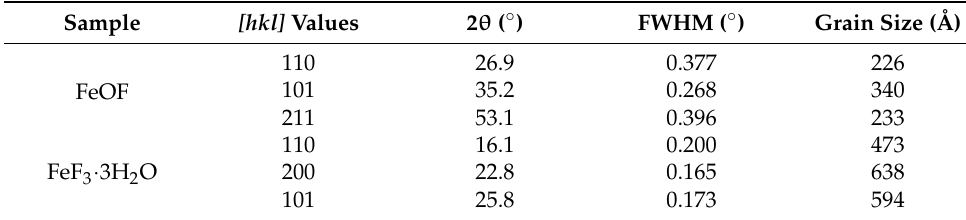
Table 1. Structural parameters of FeOF and FeF3 · 3H2O determined from XRD data.